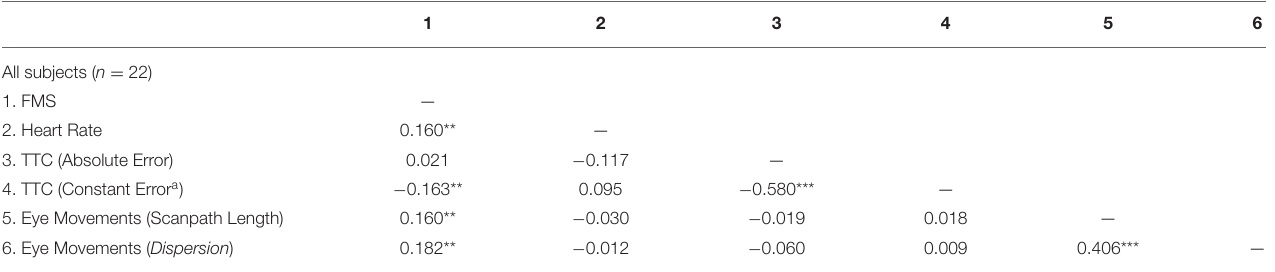
TABLE 3 | Repeated Measures correlations among time and frequency domain measures ( n = 22).